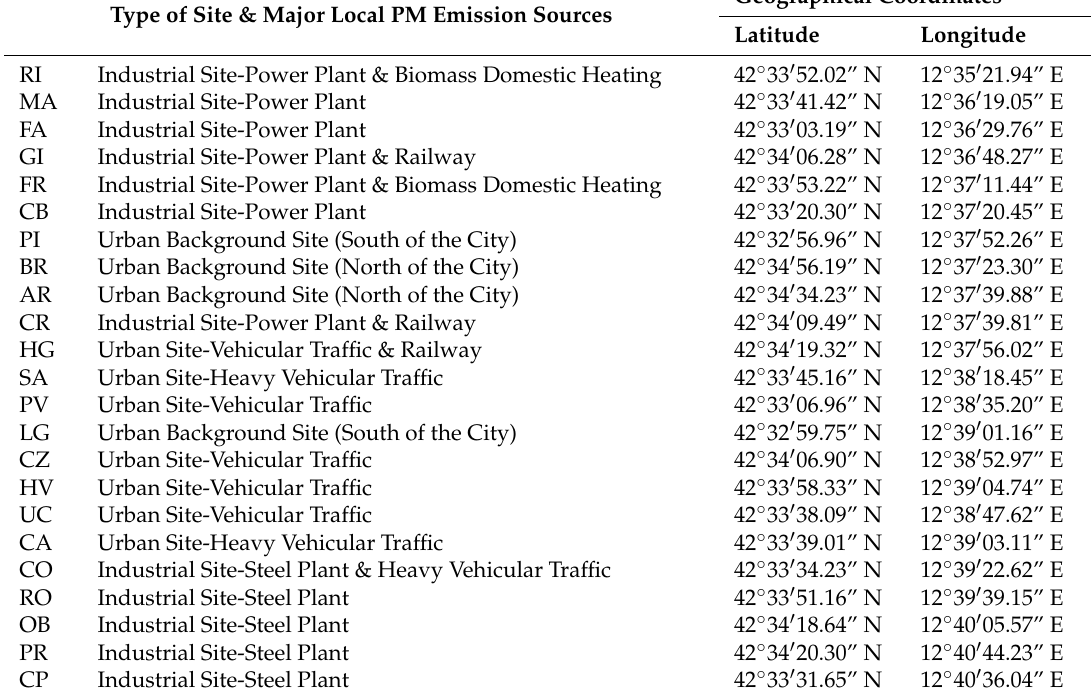
Type of Site & Major Local PM Emission